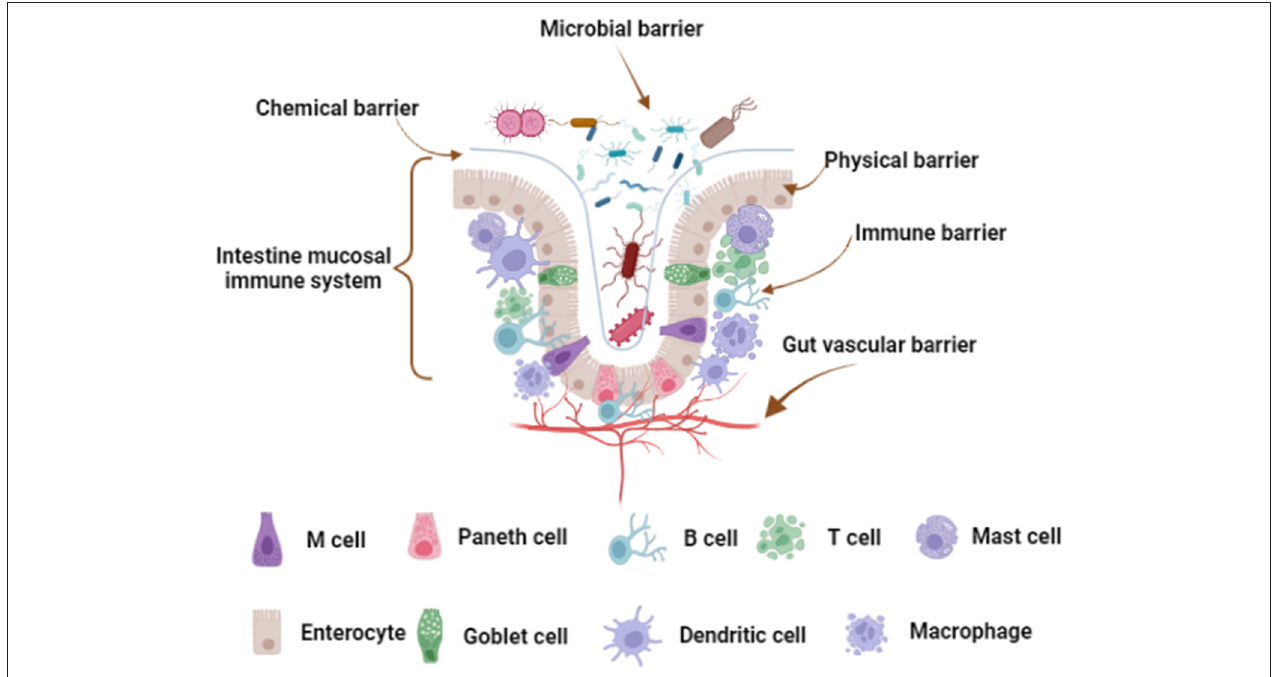
FIGURE 1 | Intestinal barrier composition. The microbial barrier is the uppermost barrier of the intestinal tract. The chemical barrier is close to the microbial barrier and is a layer of mucous membrane. Physical barrier, also known as mechanical barrier, has mucosal epithelium, lamina propria and muscularis mucosae. Mucosal epithelium has an inherent epithelium, including immune cells and enterocytes, and there are tight junctions between the cells. The immune barrier is located below the lamina propria, including various immune cells scattered in the LP and MLNs. The gut vascular barrier is the deepest protective layer of the intestinal tract. The figure was created with